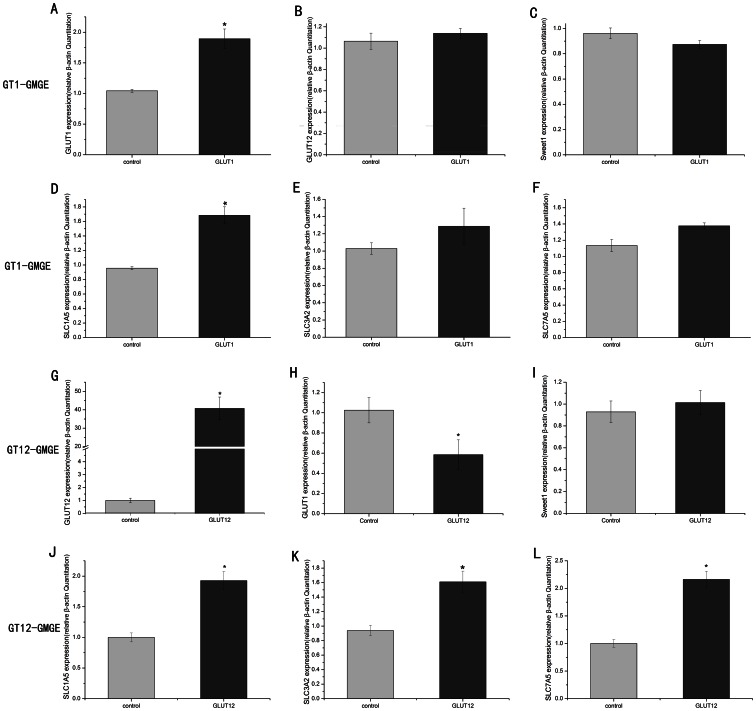
GLUT1 (A and H), GLUT12 (B and G), Sweet1 (C and I), SLC1A5 (D and J), SLC3A2 (E and K) and SLC7A5 (F and L) mRNA expression in GT1-GMGE and GT12-GMGE respectively.In GT1-GMGE, The GLUT1 (A) and SLC1A5 (B) mRNA in GT1-GMGE had significantly greater than GMGE (P<0.05), However the SLC7A5 (C) and SLC3A2 (D) mRNA was higher than GMGE but not significantly (P>0.05). In GT12-GMGE, the GLUT12 mRNA expression was increased significantly (P<0.01), while the GLUT1 expression was reduced significantly in GT1-GMGE (P<0.01). Furthermore, the SLC1A5, SLC3A2, SLC7A5 mRNA expression were all increased significantly (P<0.01). Data are expressed as means ± SE (n = 3). *P<0.01, compared with GMGE.